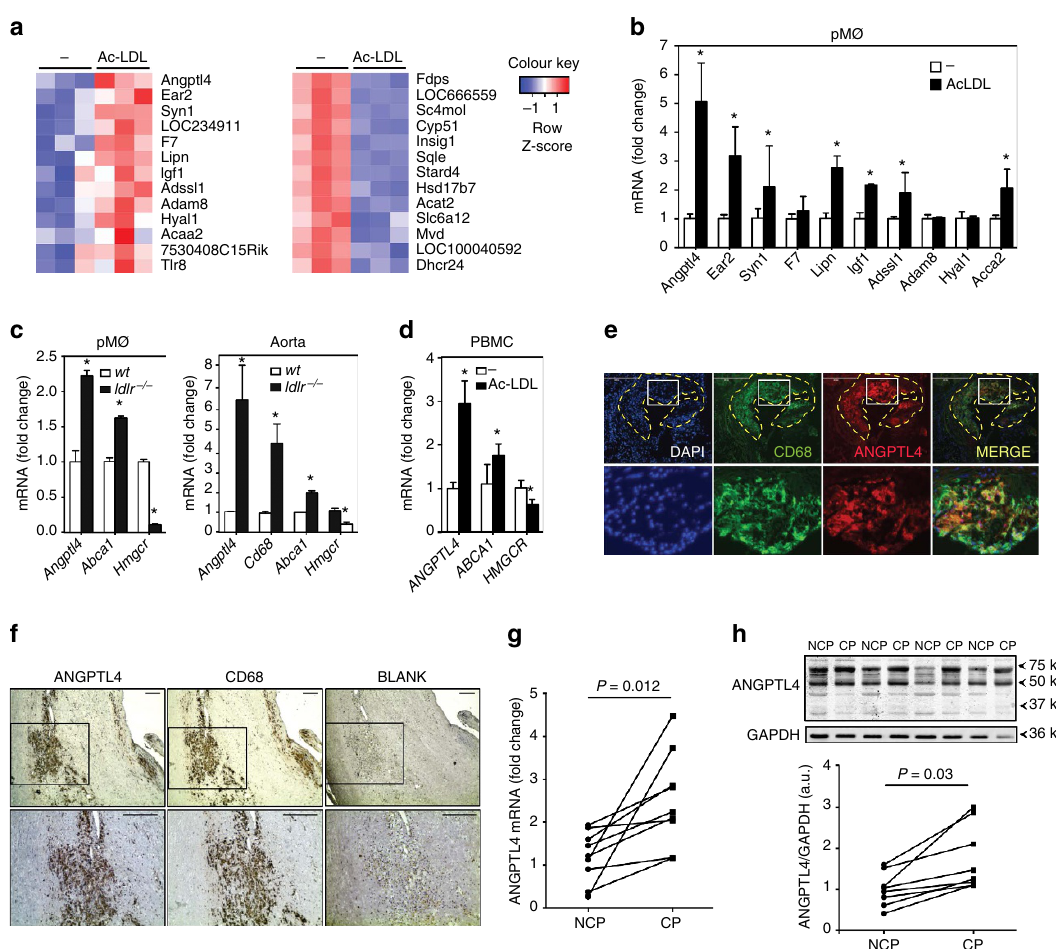
Figure 1 | ANGPTL4 is expressed in macrophages accumulated in atherosclerotic plaques. ( a ) Heat map representation of gene expression from microarray data comparing mouse peritoneal macrophages incubated with or without Ac-LDL (120 m gml (cid:2) 1 ) for 24h. Left panel shows upregulated genes ( P o 0.05, unpaired t -test; fold change Z 1.4) and right panel shows downregulated genes ( P o 0.05, unpaired t -test; fold change Z 2.08) upon Ac-LDL treatment compared with non-treated cells. Samples were analysed in triplicate. ( b ) qRT-PCR validation of selected genes upregulated in the microarray in mouse peritoneal macrophages treated with or without Ac-LDL for 24h. qRT-PCR analysis of Angptl4 expression levels in macrophages ( c , left) and